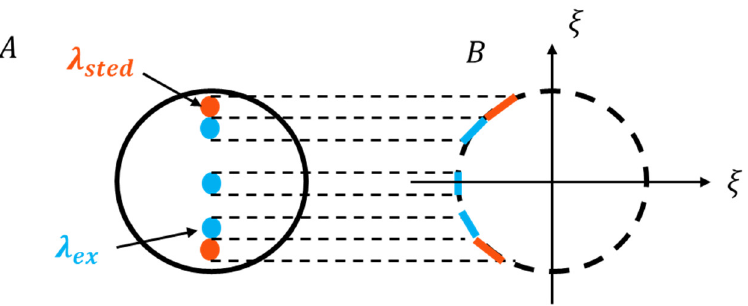
Figure 5. Use of correlative SIM-STED for 3D imaging. ( A ) The beam positions on the objective back focal plane. ( B ) Spatial frequency distribution of illumination.